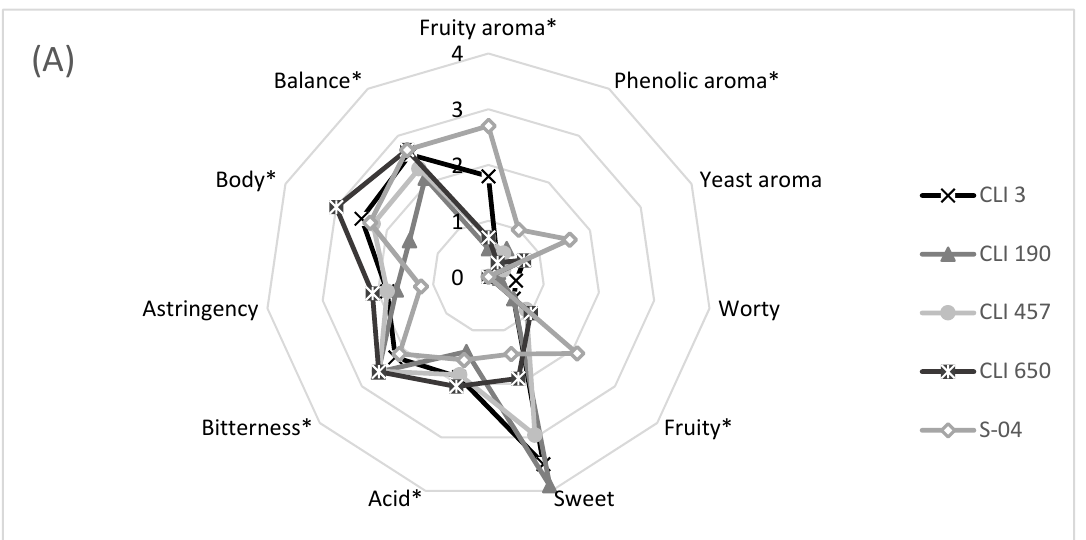
Figure 4. Fermentation kinetics in 1 L fermentation for 13 studied strains. Each value is the mean of three trials expressed in g CO 2 lost per day.